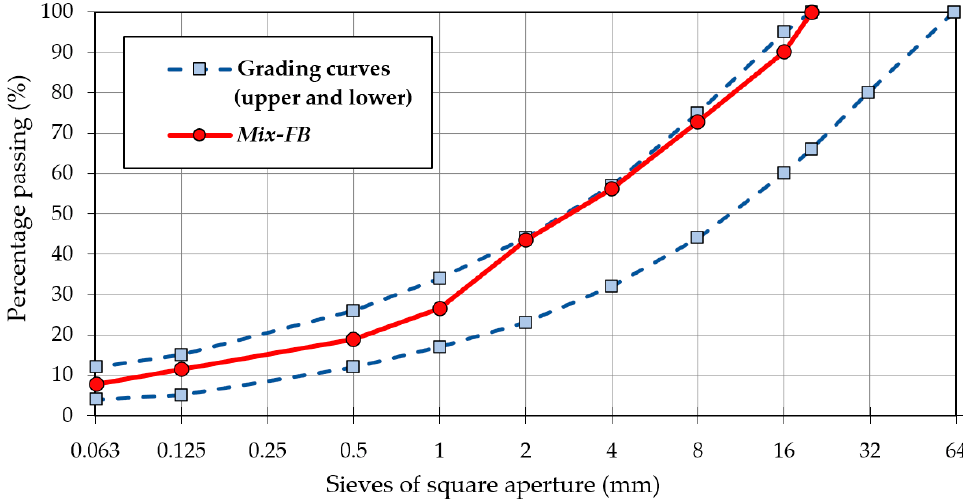
Figure 9. Particle size distribution of the mineral mixtures with boundary curves according to recommendations [44].